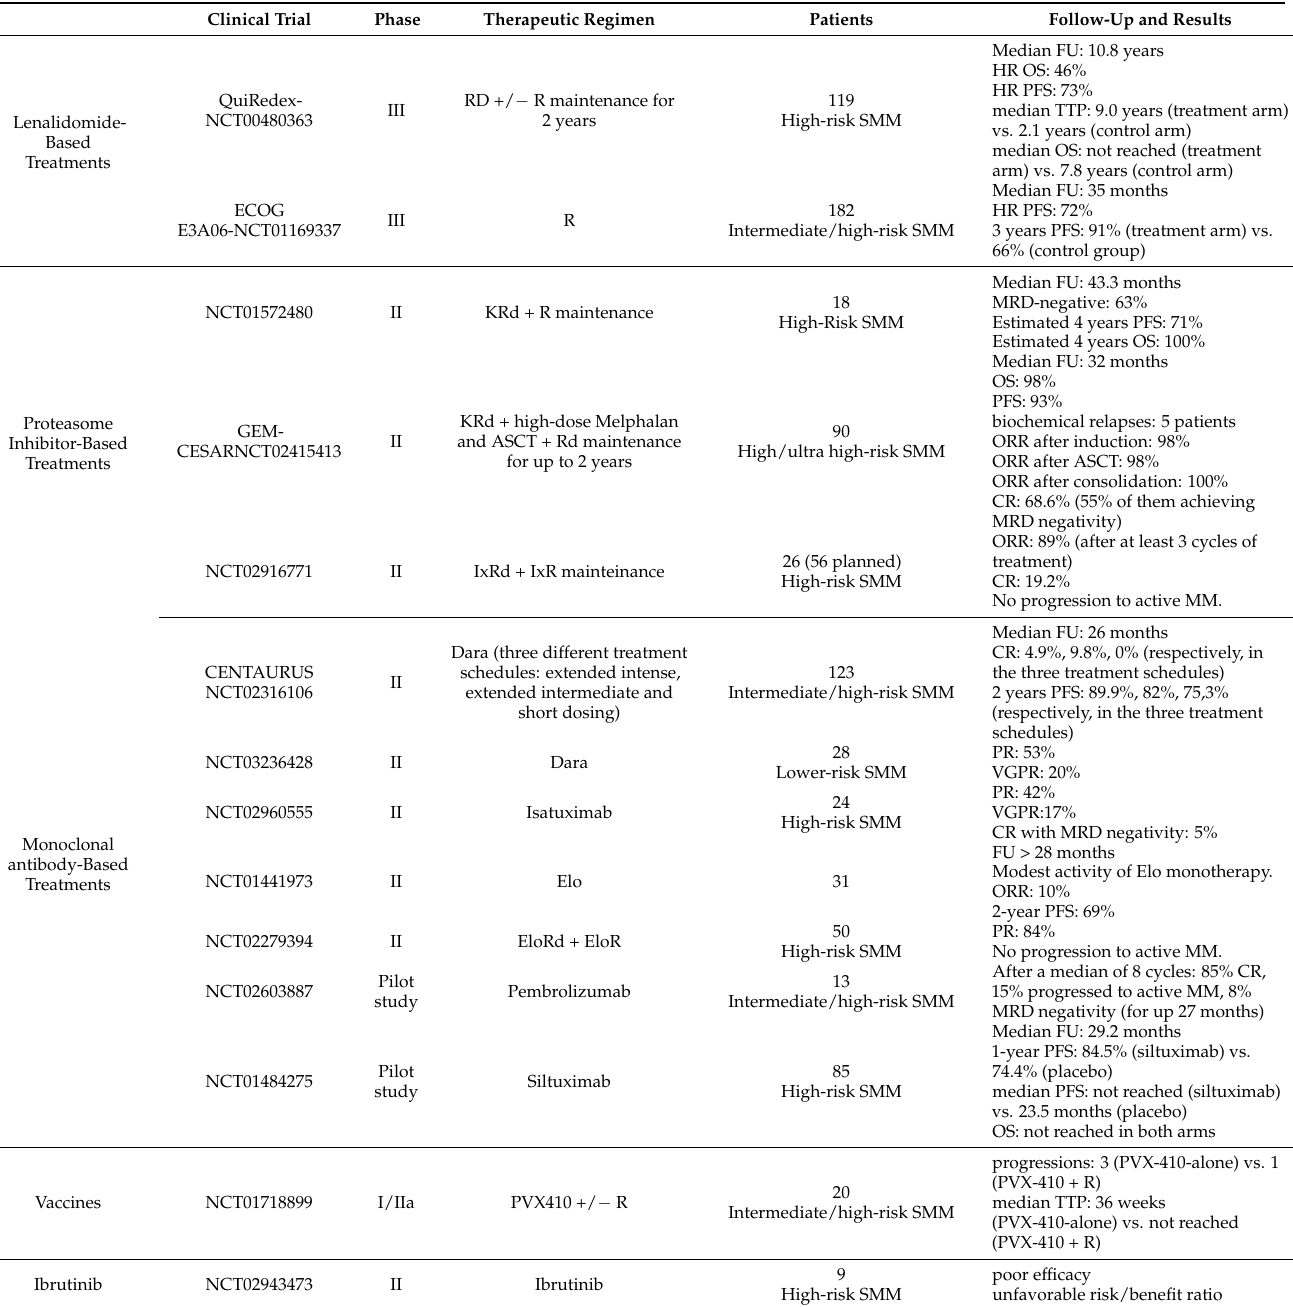
Table 3. Treatment options with novel agents for